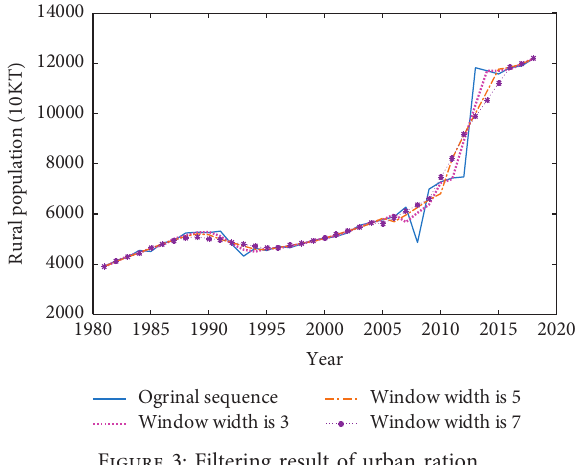
Figure 3: Filtering result of urban ration.